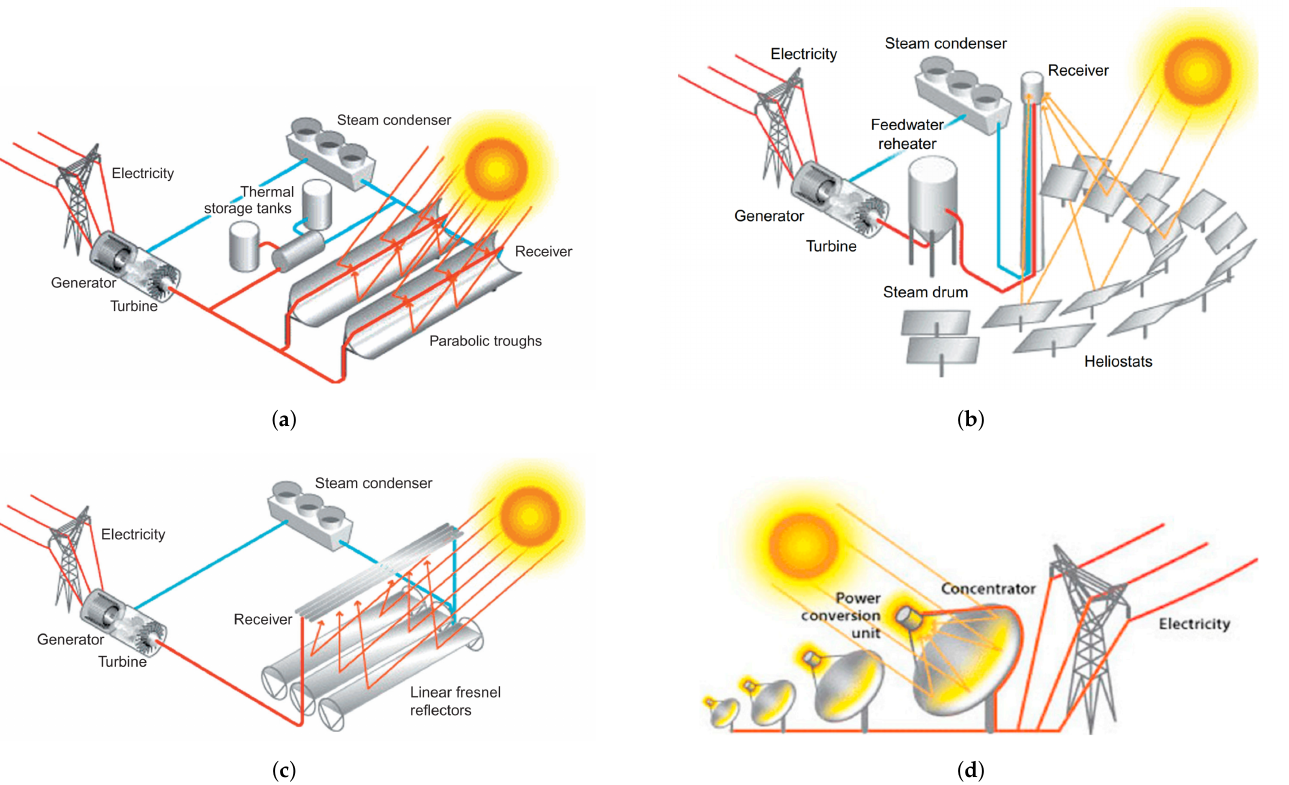
Figure 8. Schematic of CSP plants, reproduced with permission from [101,102]: ( a ) PT plant. ( b ) ST plant. ( c ) FR plant. ( d ) SD